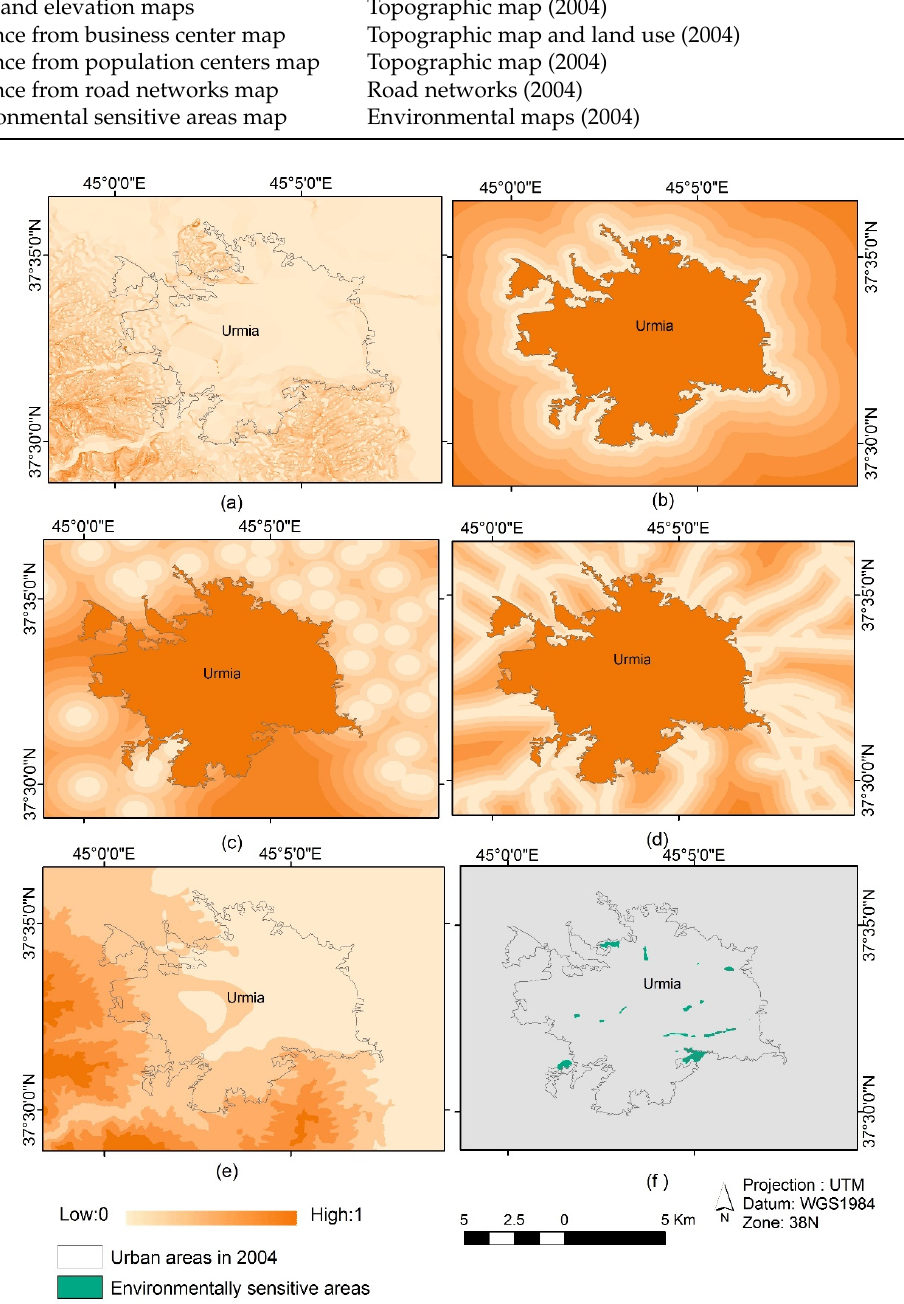
Figure 5. Normalized data of urban growth process in Urmia. ( a ) Slope map; ( b ) Proximity to major business center map; ( c ) Proximity to population center map; ( d ) Proximity to major roads map; ( e ) Elevation map; and ( f ) Environmentally sensitive areas map. Slope and elevation maps with resolutions 30 m × 30 m were derived from a digital elevation model extracted from topographic maps produced by the national cartographic center of Iran. Slope and elevation maps are important factors in modeling urban growth because they input realism